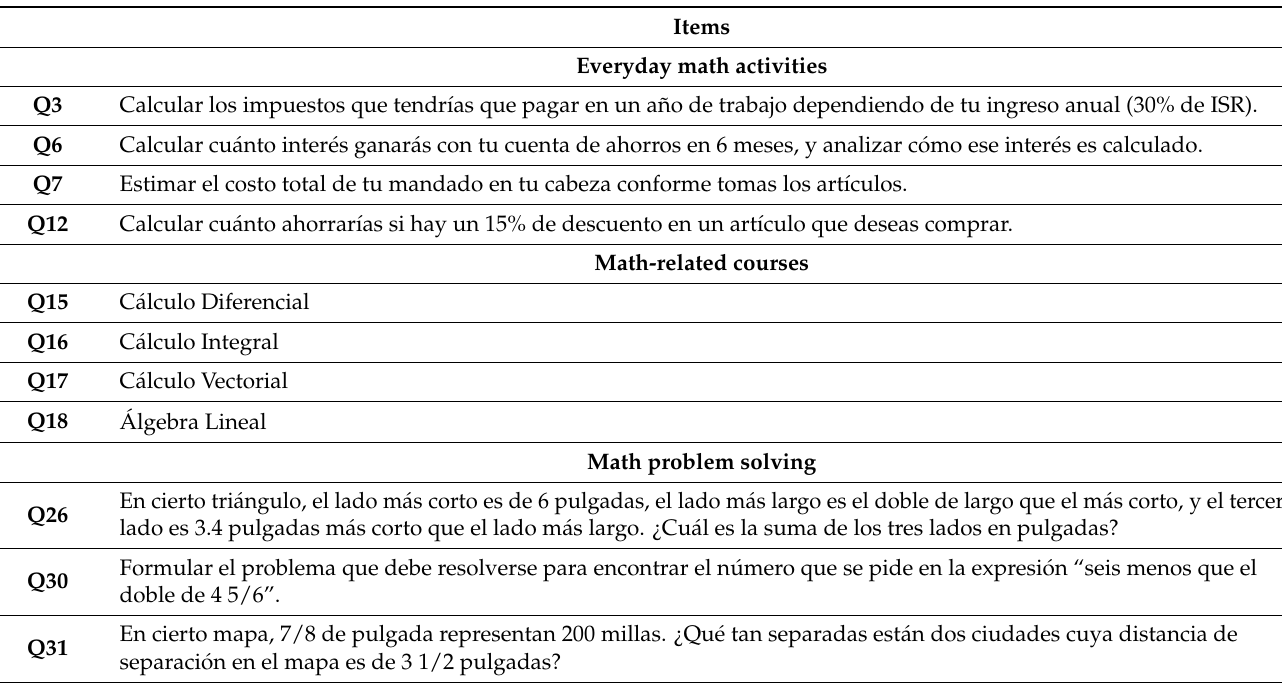
Table 4. Validated items of the instrument after adjustment of the CFA